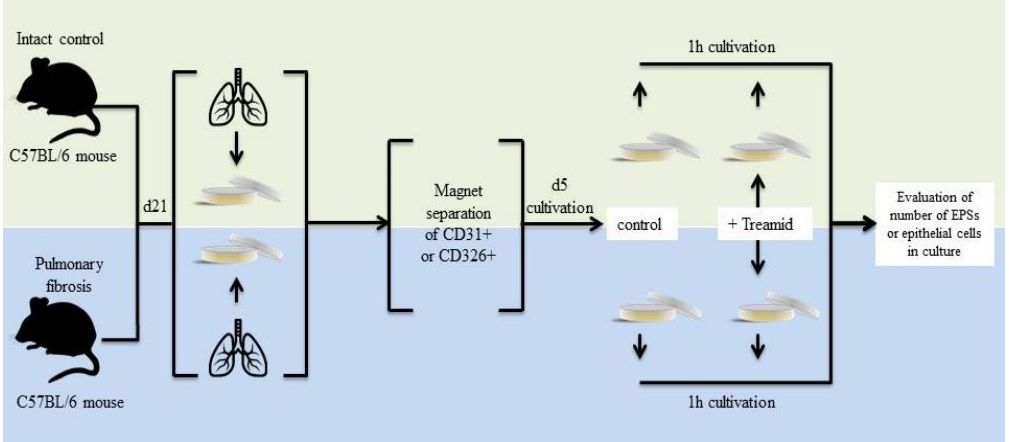
Figure 6. Graphical scheme of the protocol for CD31 + lung endothelial cells and CD326 + lung epithelial cells cultivation with Treamid.